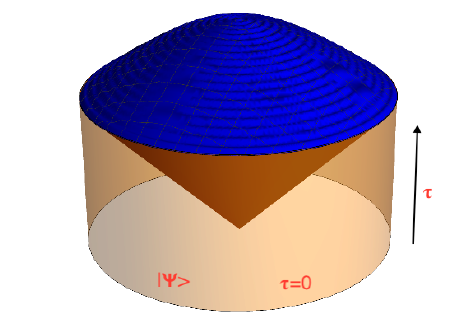
Figure 1 . A depiction of an asymptotically globally AdS geometry, with (E-frame) time evolu- tion ending in a crunch (blue), dual to a boundary CFT in global de Sitter space with relevant deformations. The cone represents the horizon which only appears in the dS-sliced